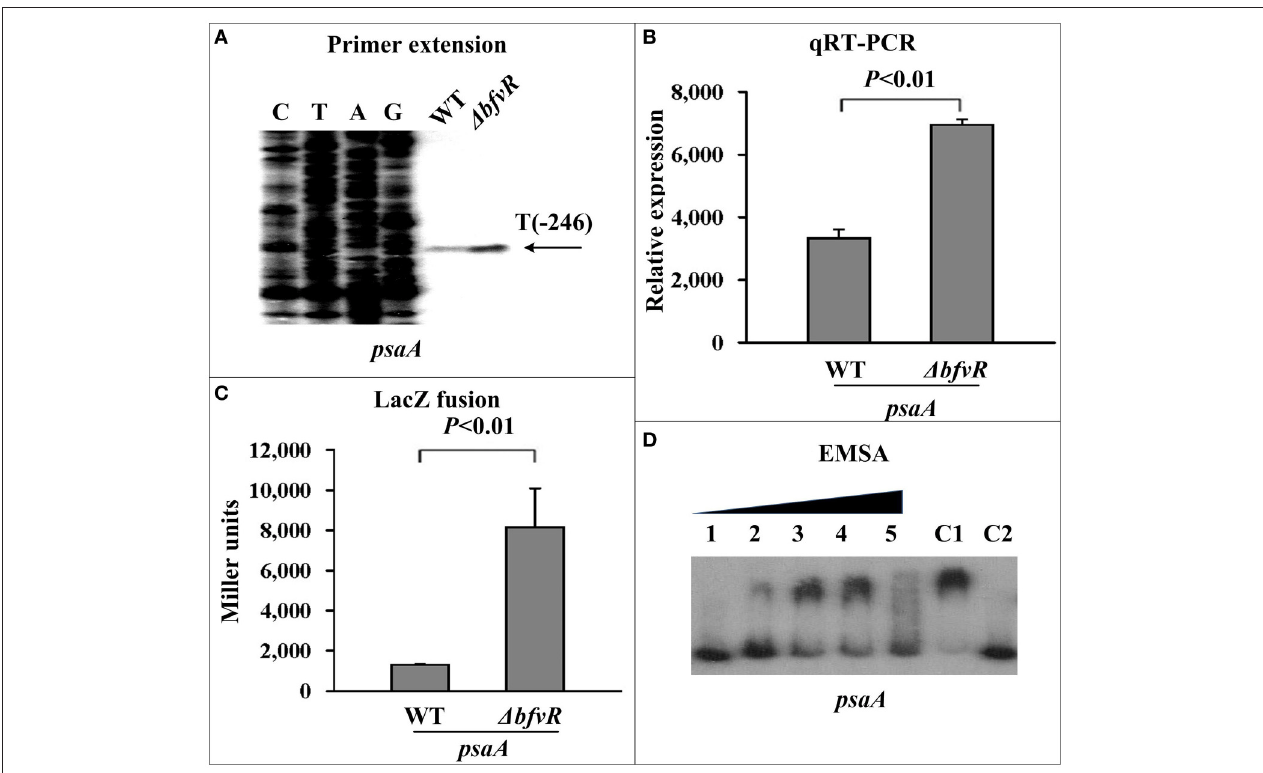
FIGURE 5 | Regulation of psaA by BfvR. Reference to Figure 2 for the annotations of primer extension (A) , quantitative RT-PCR (B) , LacZ fusion (C) , and EMSA (D) . The promoter-proximal region from − 491 to + 65 was amplified.